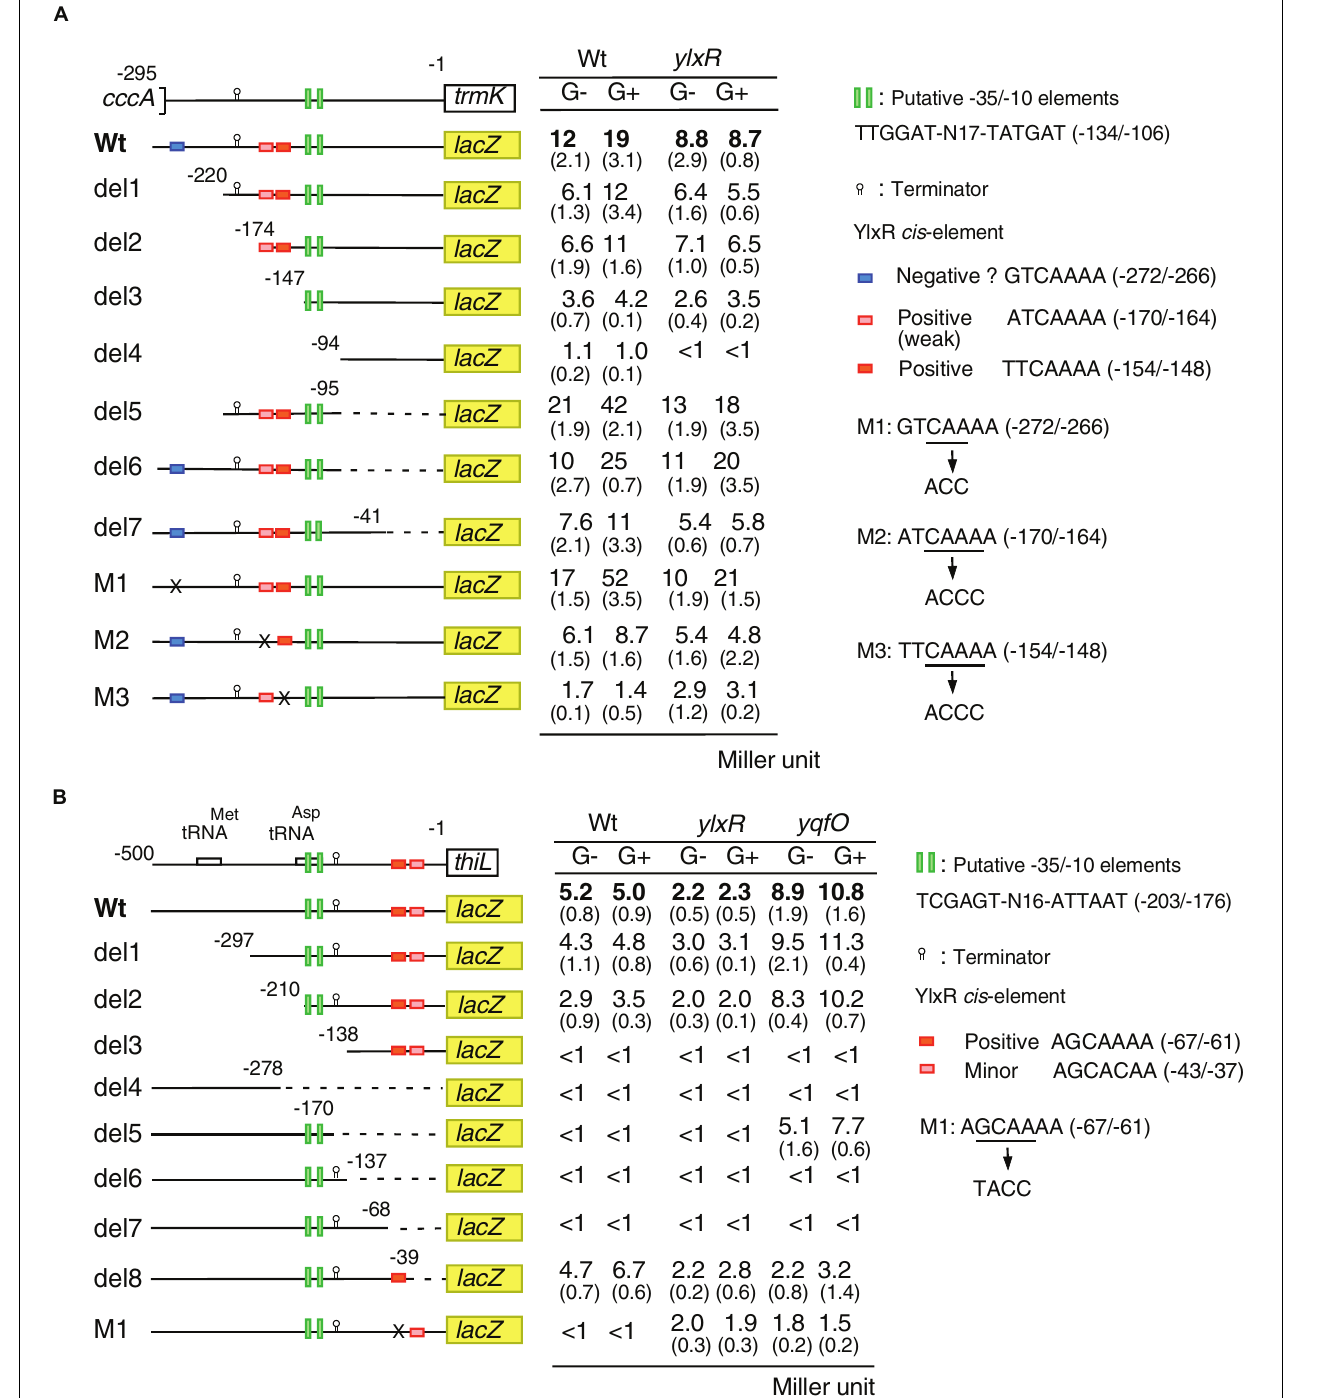
FIGURE 5 | Expression of various P trmK-lacZ and P thiL-lacZ fusions. (A) P trmK-lacZ . (B) P thiL-lacZ. Strains were grown in sporulation medium with or without 2% glucose and sampled hourly from T-2 to T2. The averages and standard deviations of the observed peak values of β -Gal activities from the three independent cultures are shown. Numbers in parentheses show standard deviations. Structures of various lacZ fusions are depicted. Numbers indicate the nucleotide positions relative to the translation start nucleotide. The boxes on the line show the genes. The relevant genotype and the addition of glucose are shown (G − or G + ). The construction of the mutated fusions is described in Supplementary Methods . Time-course data in the strains with wild-type fusion are shown in Figure 4 .